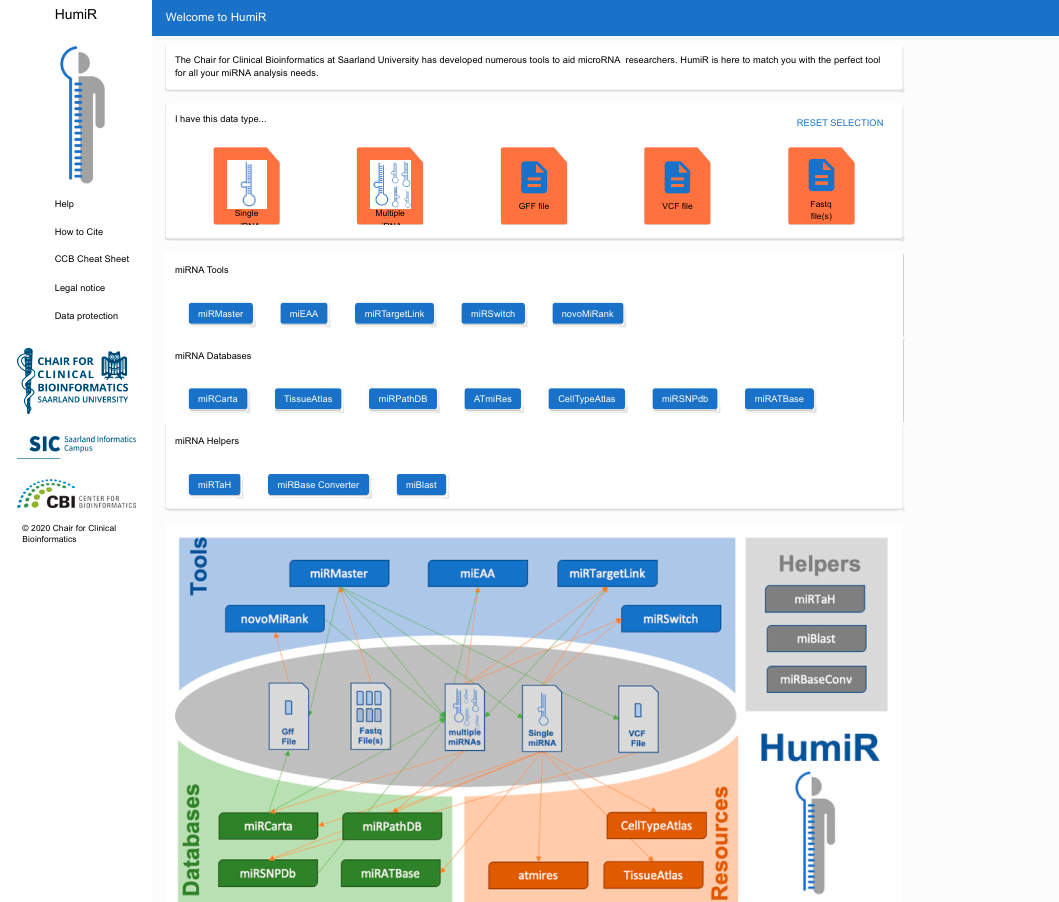
Figure 3. Web presence of HumiR. Screenshot of the web interface of HumiR. Users can select their input or output file types and all respective tools are enabled while all others are disabled. Although currently the workflows must be executed manually, the aim of HumiR is a fully integrated workflow management of all